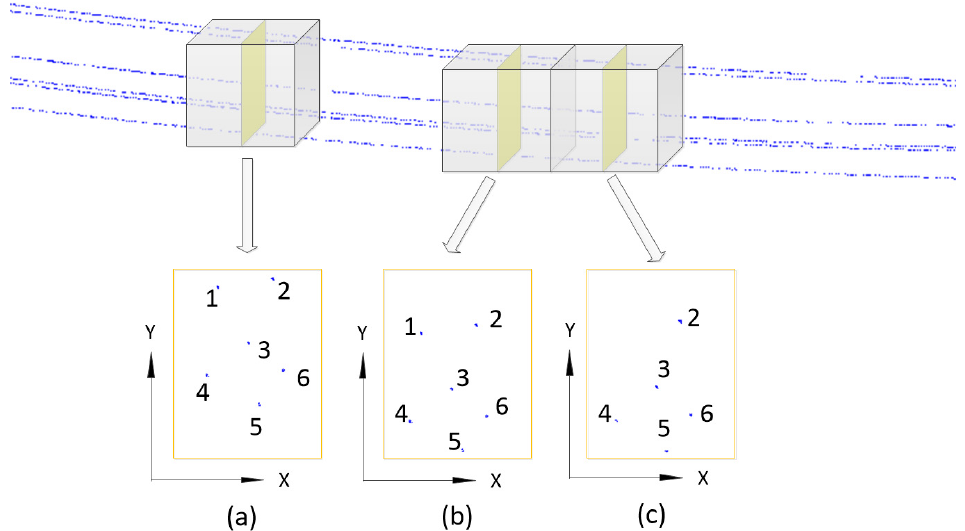
Figure 1. Similarity detection by segmentation. The corresponding center points among different profiles (represented by ( a – c )) for the same power-line span are given the same number. In instances of missing data, the points do not